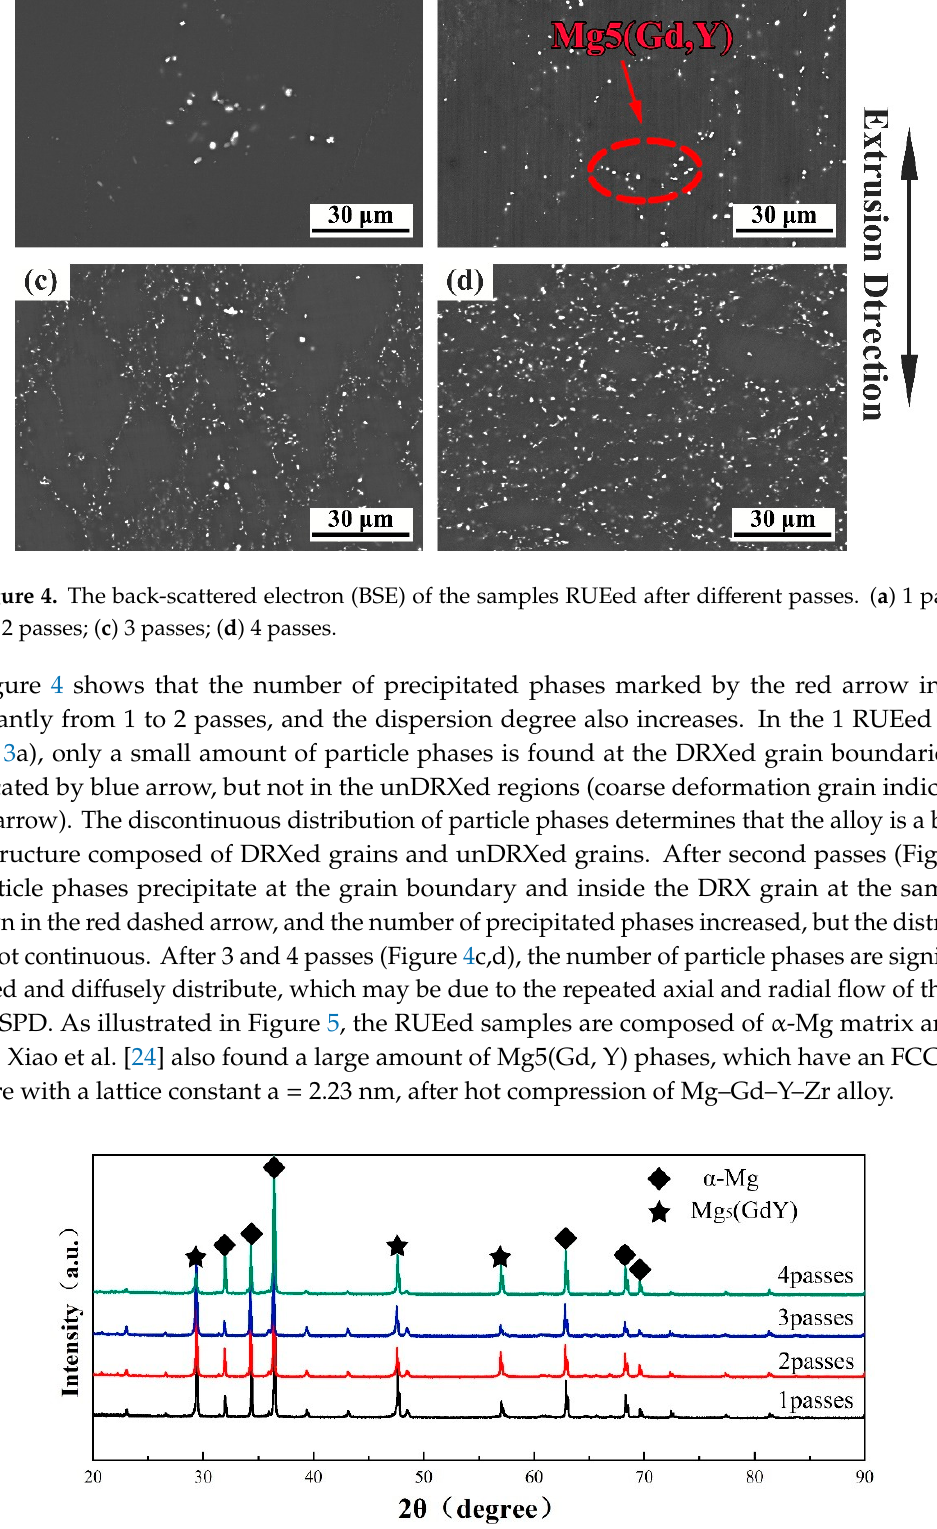
Figure 3. The OM microstructure of the samples RUEed after different passes. ( a ) 1 pass; ( b ) 2 passes; ( c ) 3 passes; ( d ) 4 passes.